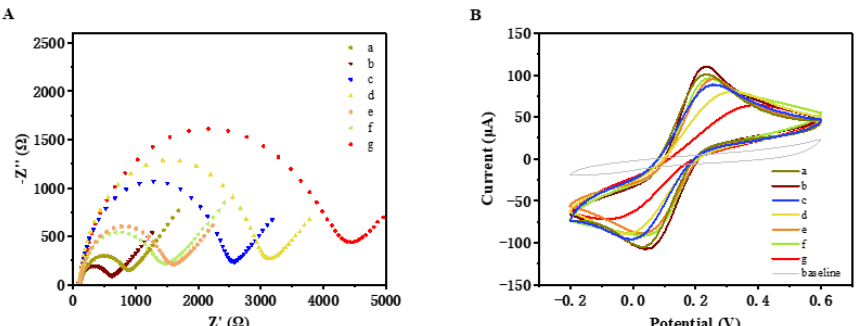
Figure 1. Characterization of electrode assembly process. ( A ) The Nyquist diagrams and ( B ) CV characterization of stepwise modification in 0.1 M PBS, 0.1 M KCl (pH 7.4) and 10 mM [Fe (CN)6] 3 − /4 − solutions at the modified electrode. (a) bare GCE. (b) Au/GCE. (c) HC/dpAu/GCE. (d) tDNA/HC/dpAu/GCE. (e) EXO III/tDNA/HC/dpAu/GCE. (f) (Au/SCX6/RGOMB-LP-AP)/EXO III/tDNA/HC/dpAu/GCE, (g) (LP-AP-MB)/EXO III/tDNA/HC/dpAu/GCE, (baseline) the CV of GCE without redox mediator.